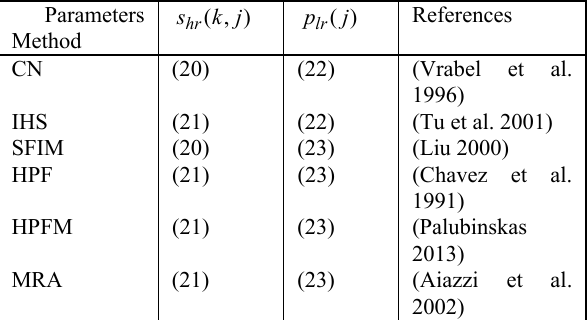
Table 4. A list of pan-sharpening methods derived from (18,